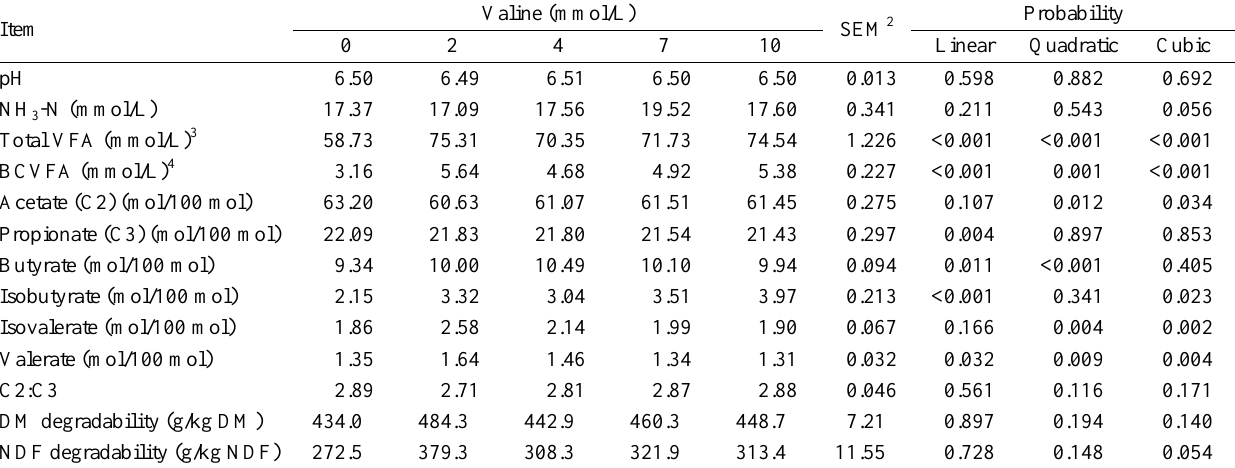
Table 1. Effect of different concentrations of valine on the ruminal fermentation characteristics, DM and NDF degradability of wheat straw in vitro